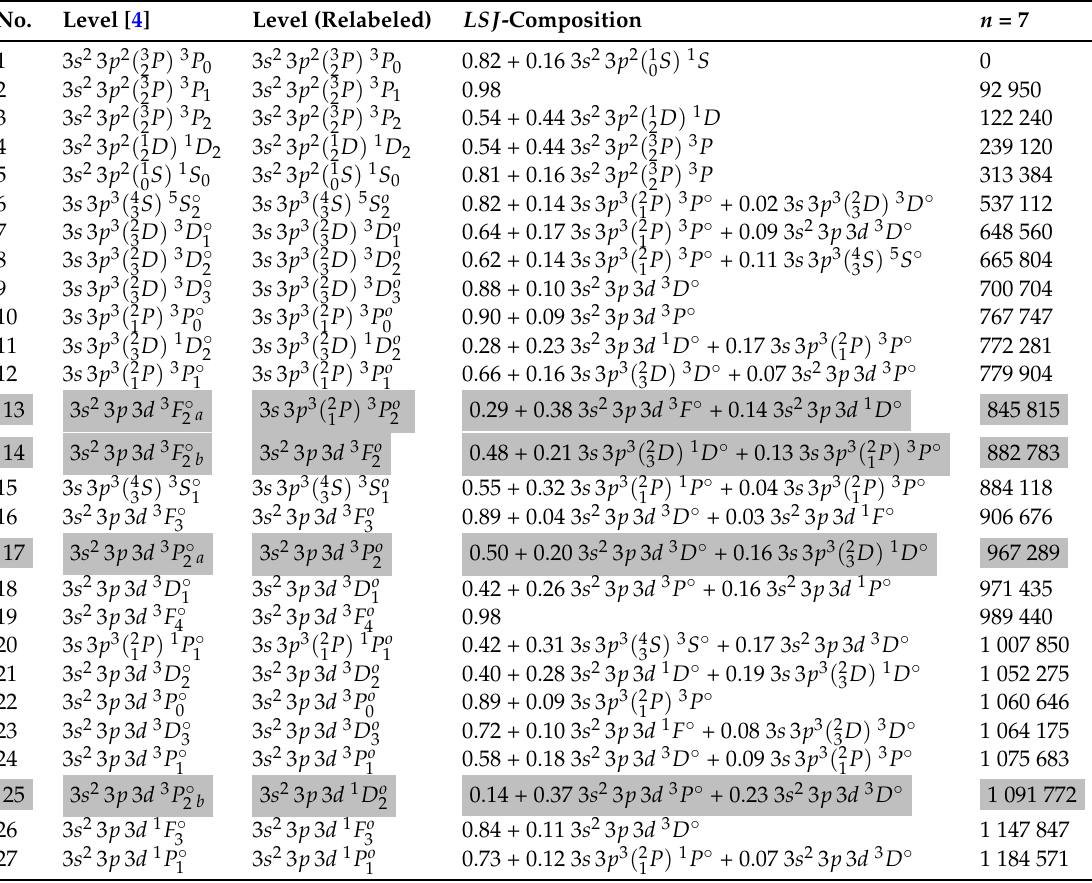
Table 1. Energy levels in cm − 1 and LSJ -composition for Si-like Sr. In the original data levels 13 and 14 had the same label and subscripts ’a’ and ’b’ were introduced to separate the levels. Using the JJ2LSJ program levels 13 and 14 are now assigned unique